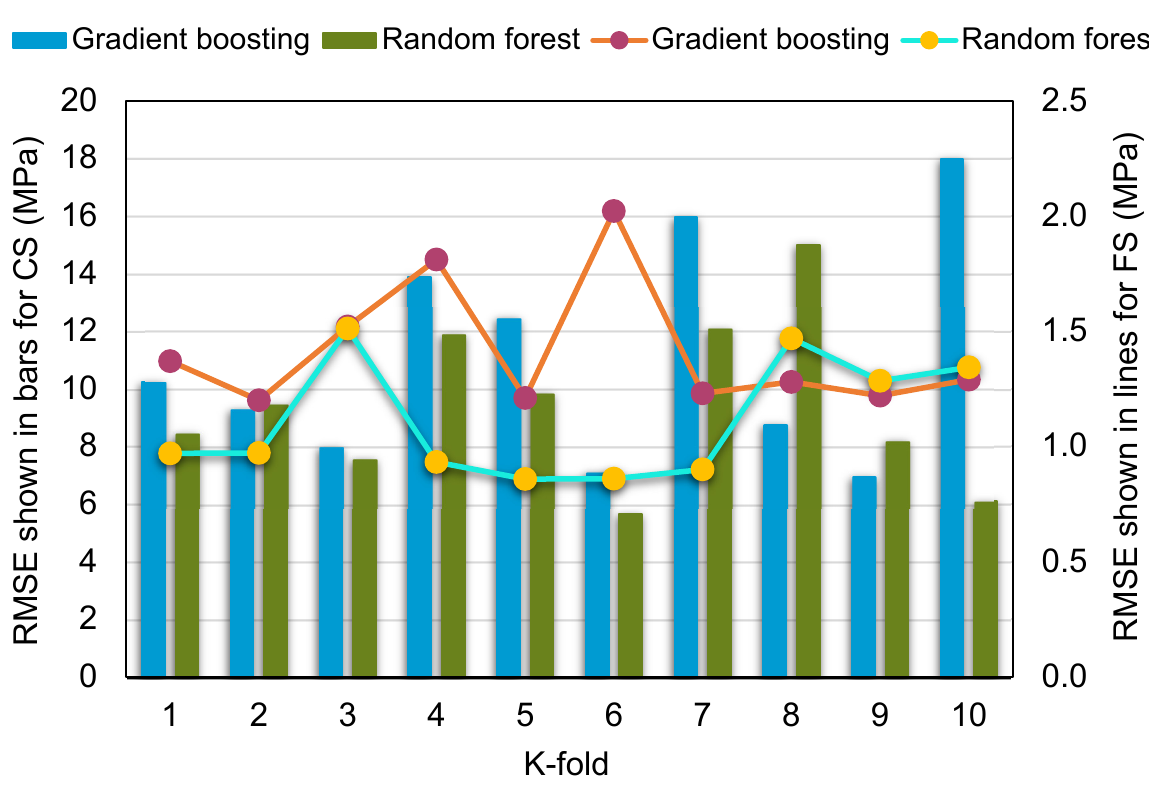
Figure 12. Root-mean-square error distribution from k-fold analysis.